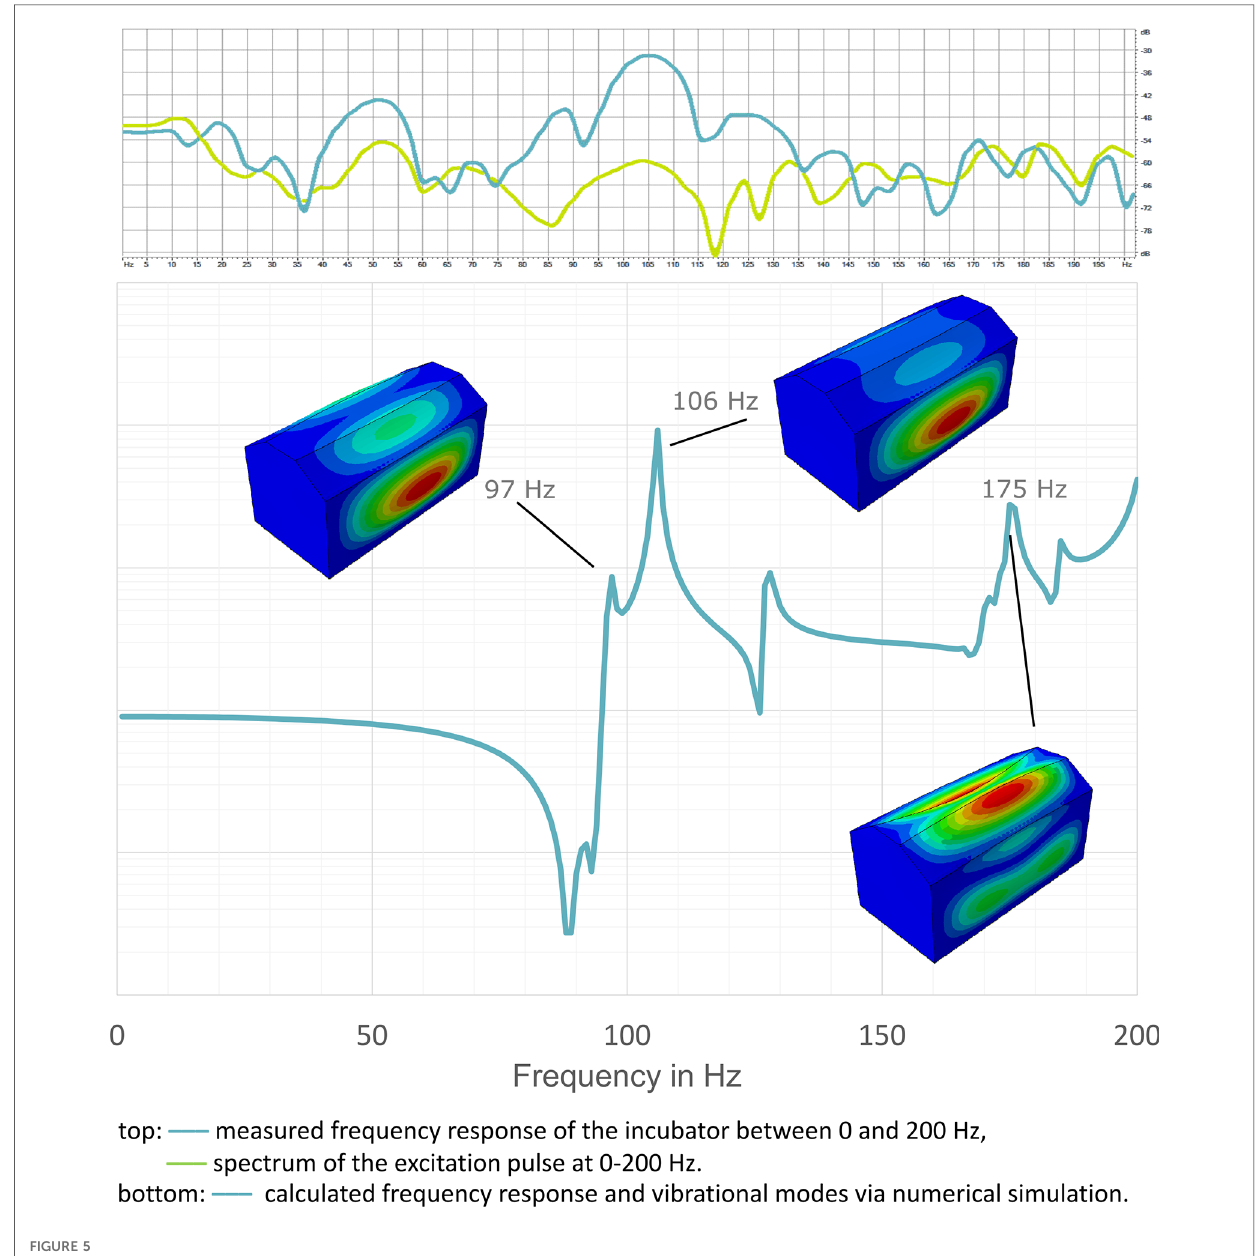
FIGURE 5 Measured (top) and simulated (bottom) resonance characteristics of the